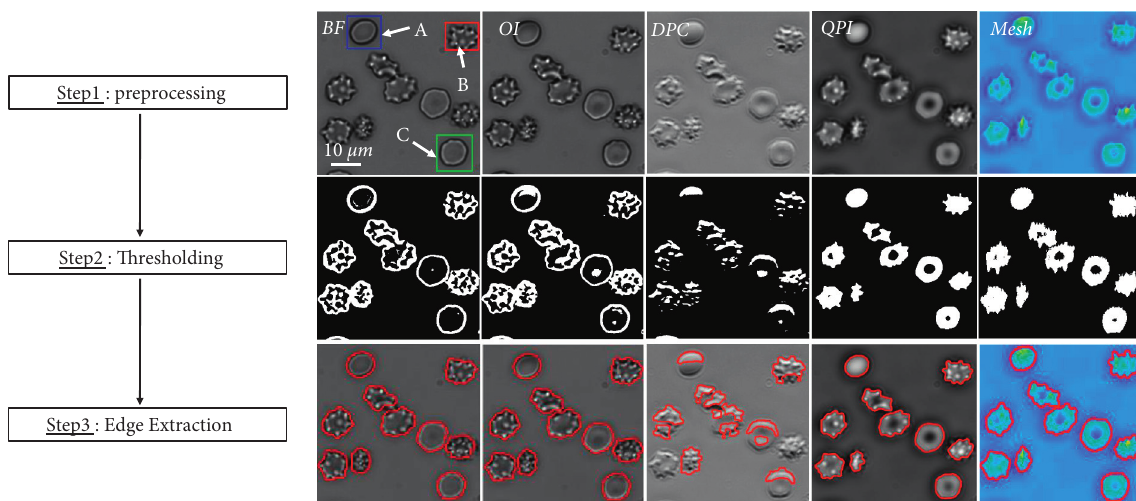
Figure 6: Segmentation and extraction effect of RBCs in different imaging modes. The images in the first line are preprocessing results of BF, OL, DPC, QPI, and mesh, where A, B, and C are the spherocyte, echinocyte, and discocyte, respectively. The images in the second line are thresholding results processed by the Otsu method. The images in the third line are edge extraction results processed by thresholding results, where the extracted cell edges are marked with red